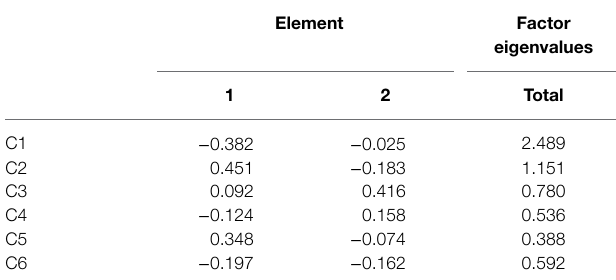
TABLE 4 | Analysis of satisfaction factors of teaching evaluation psychology management.